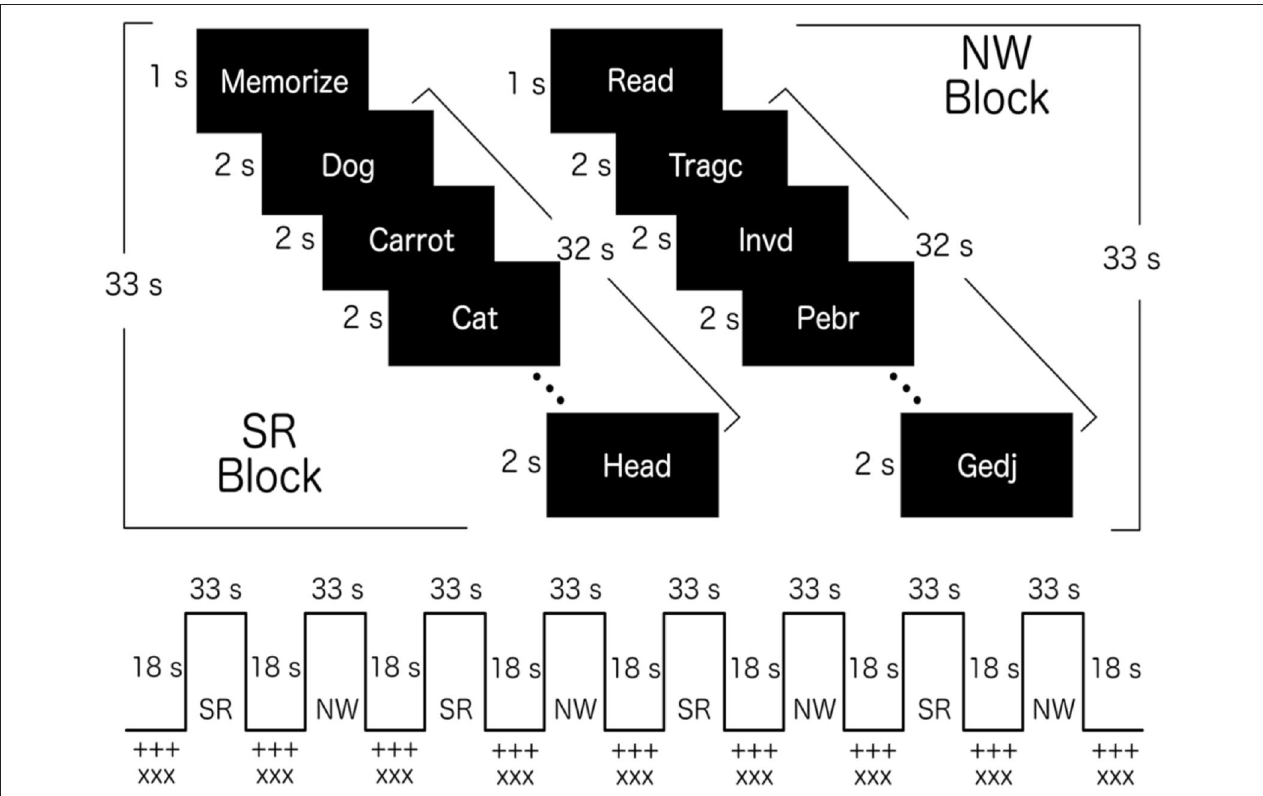
FIGURE 3 | Word-List Learning Paradigm (WLLP). Schematic representation of WLLP showing the structure of each task block (top): Semantically related (SR) block; and non-words (NW) block. The words presented in the image are only illustrations. The experiments were performed with words in Portuguese. The fMRI block sequence is also presented (bottom) showing an example with SR block (participants were randomly assigned to start with SR block or with NW